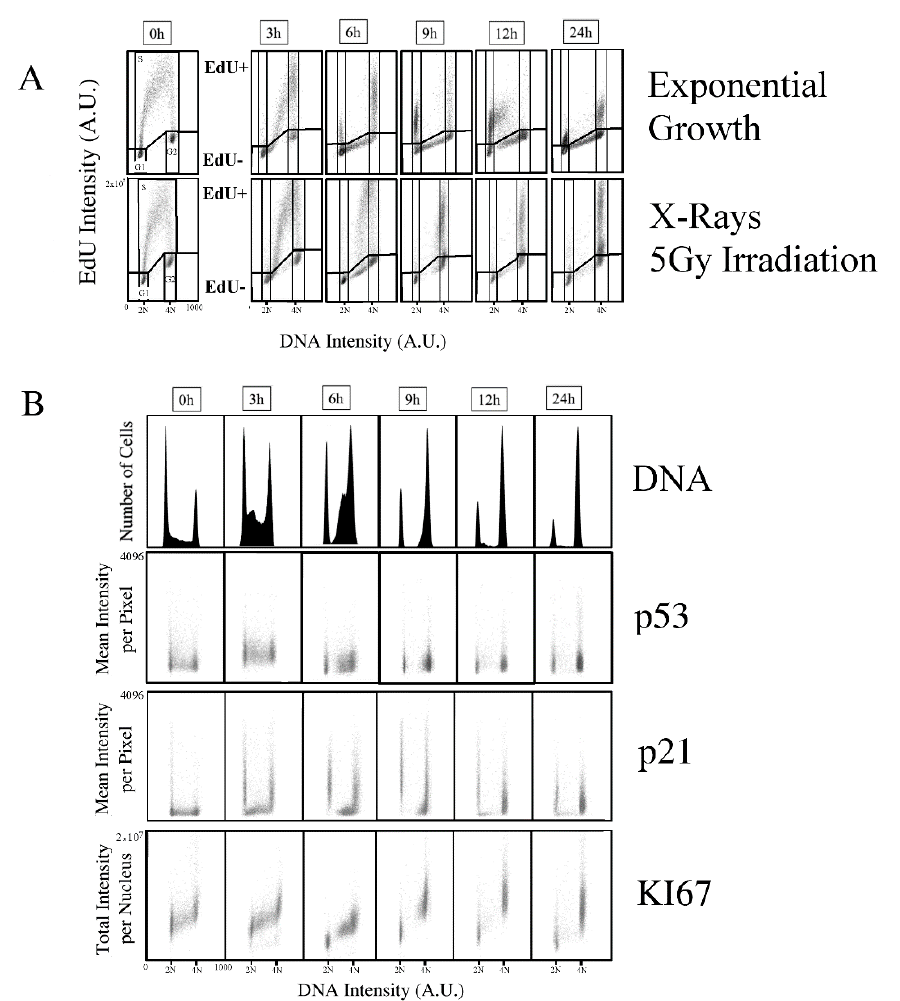
Figure 1. Image cytometry analysis of the cell-cycle progression after X-ray irradiation. ( A ) Pulse and chase analysis applied to control and irradiated cells after a pulse of EdU followed by washing and chasing with fresh medium. At time 0-h, only actively replicating cells incorporate (EdU+) the synthetic analogue during the 20 min of incubation. The evolution of the different populations was then followed by measurement of the DNA content (see Material and Methods). ( B ) Histograms report the DNA content distribution of the entire cell population ( n > 5000). Dot plots report the expression profile of p53, p21, and KI67 in relation to the DNA content at the indicated time after the irradiation. Reported data refer to a representative experiment.